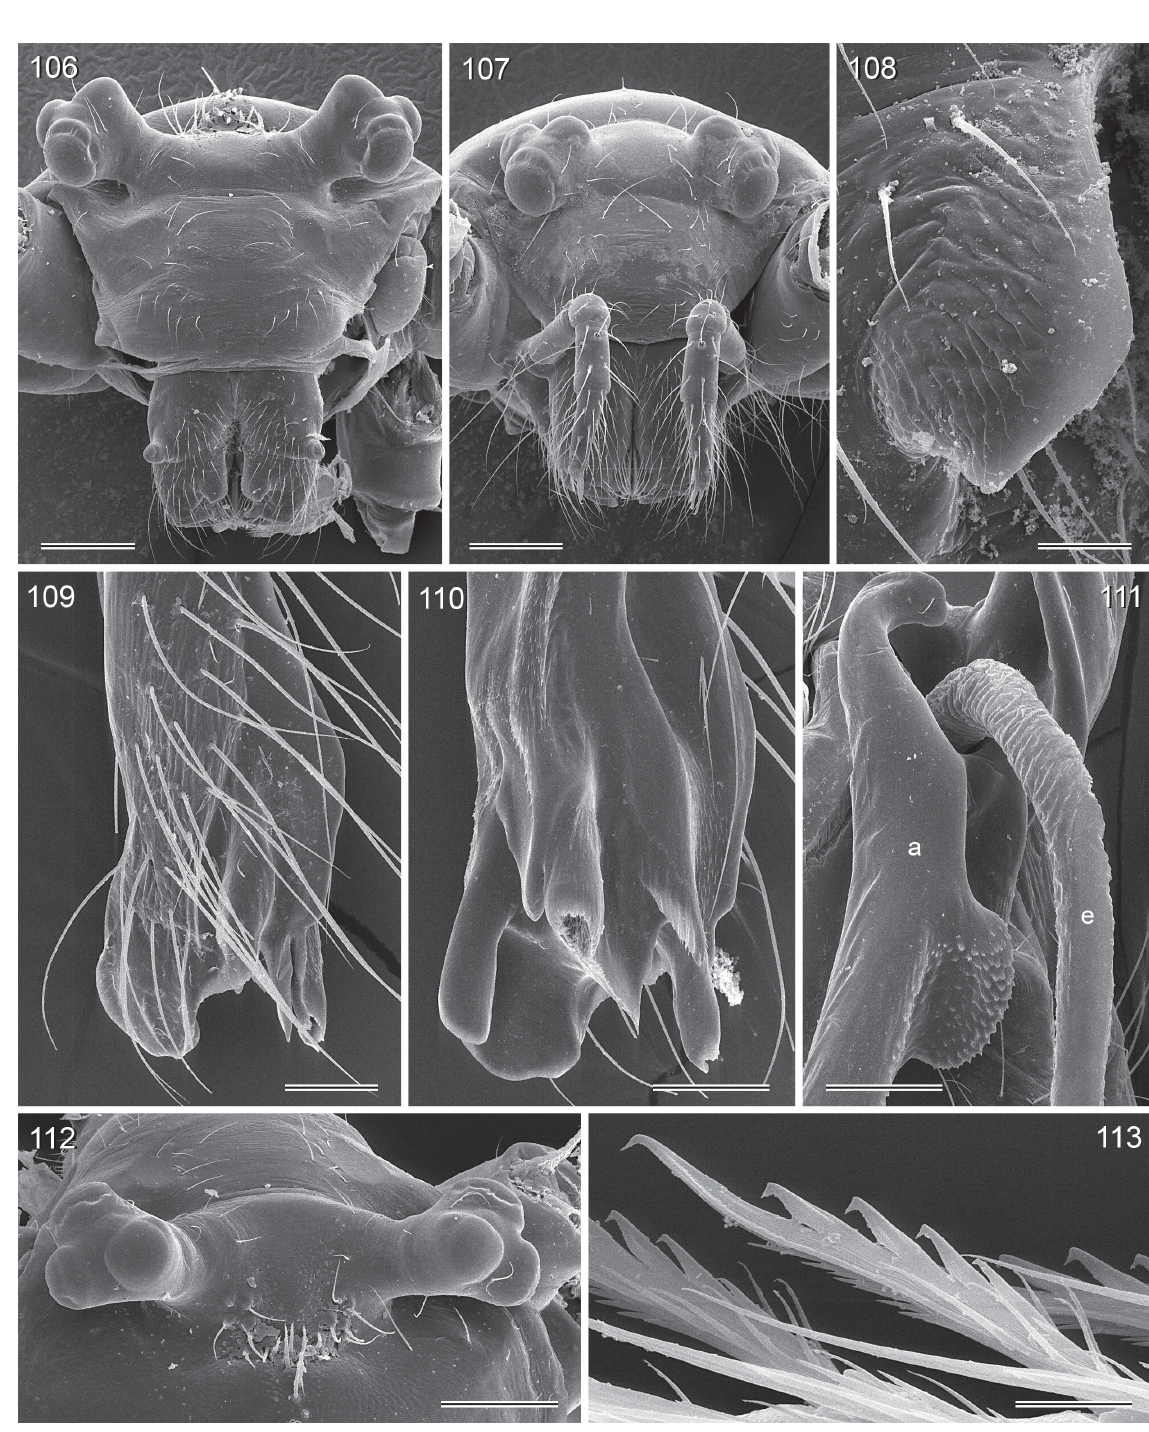
Figs 106–113. Pholcus tambunan Huber sp. nov., SeM micrographs (ZFMK, Ar 15711, 15715). 106–107 . Male and female prosomata, frontal views. 108 . right male cheliceral apophysis. 109 . right procursus, retrolateral view. 110 . Left procursus, prolateral view. 111 . Proximal parts of left appendix and embolus. 112 . Male ocular area, dorsal view. 113 . Comb-hairs on male tarsus 4. Scale bars: 106– 107, 112 = 200 µm; 108 = 20 µm; 109–111 = 100 µm; 113 = 10